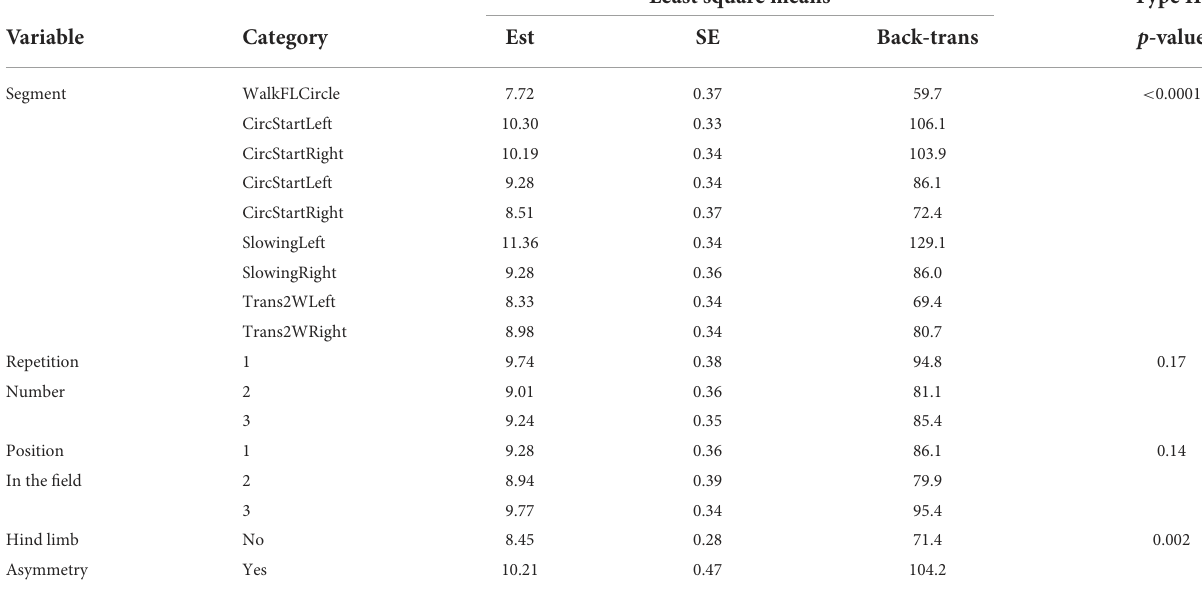
TABLE 3 Least square means (478 observations, 11 drivers and 9 horses) from model results with segment maximum rein tension as the outcome variable (modeled square-root transformed) and p-values for the corresponding main effects. Least square